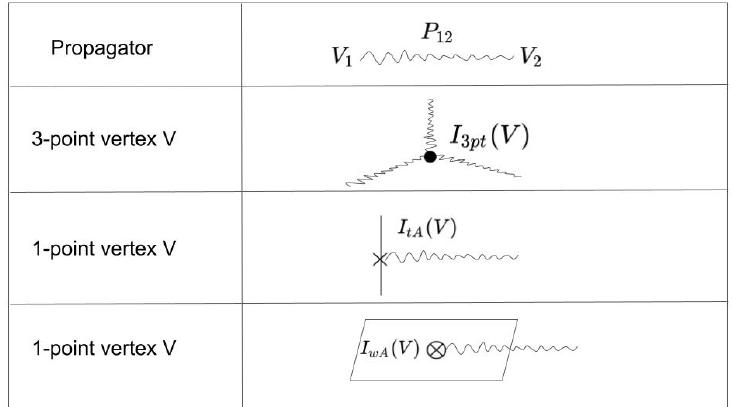
Figure 7: A table of ingredients of the Feynman diagrams in the 5d Chern-Simons theory coupled with the line and the surface